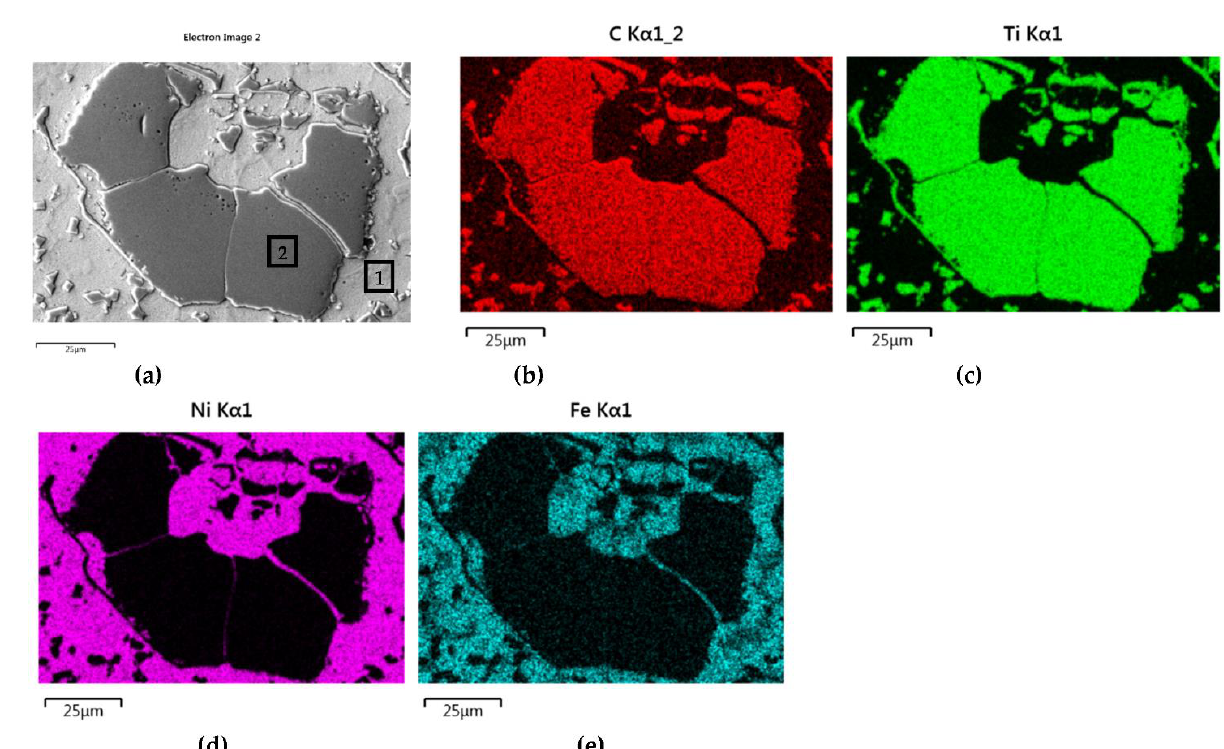
Figure 7. NiBSi-TiC layer: SEM micrograph with points of the quantitative analysis marked ( a ) and surface distributions of C ( b ), Ti ( c ), Ni ( d ), and Fe ( e ).